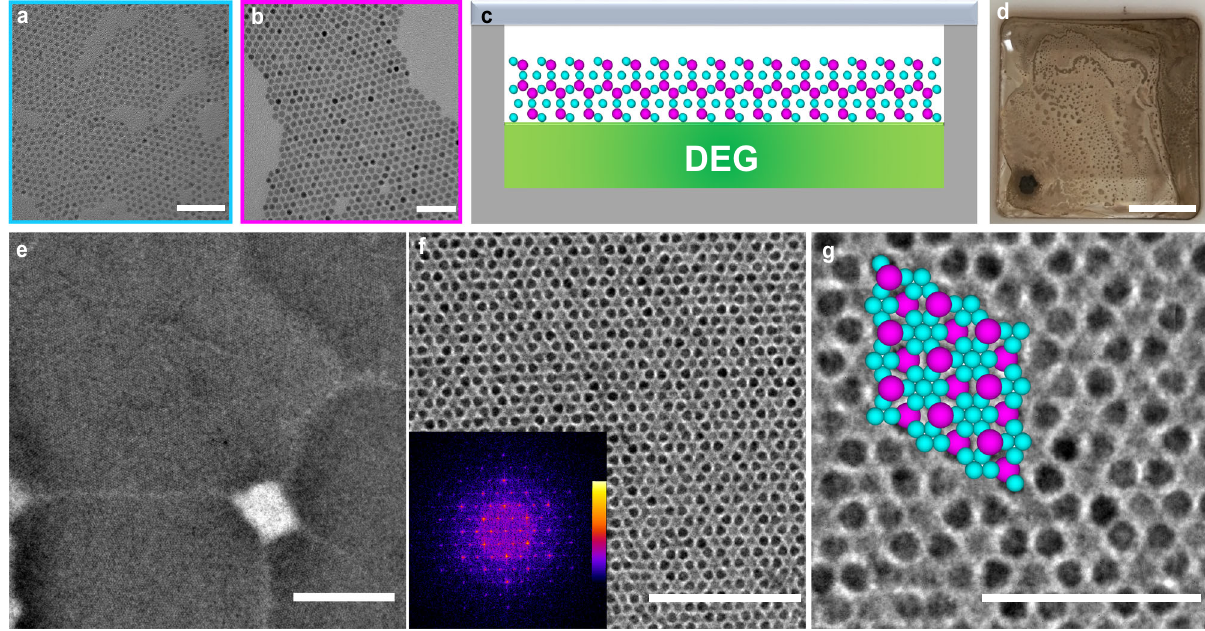
Fig. 2 Self-assembled BNSLs in bulk. TEM images of ( a ) S CdSe NCs, ( b ) L PbSe NCs. ( c ) Schematic illustration and ( d ) an optical image of the BNSLs formation at the liquid – air interface. ( e ) A TEM image of self-assembled BNSL at low magni fi cation. ( f ) – ( g ) BNSL composed of CdSe and PbSe NCs showing an MgZn 2 -like structure viewed along the [0001] projection at different magni fi cations. The hexagonal symmetry can be visualized from a false- colored Fourier transform (inset of f ) with a MgZn 2 structure model (overlay in g ) viewed along the [0001] projection. Scale bars: 50 nm ( a ), 50 nm ( b ), 0.5 cm ( d ), 500 nm ( e ), 100 nm ( f ) and 50 nm ( g